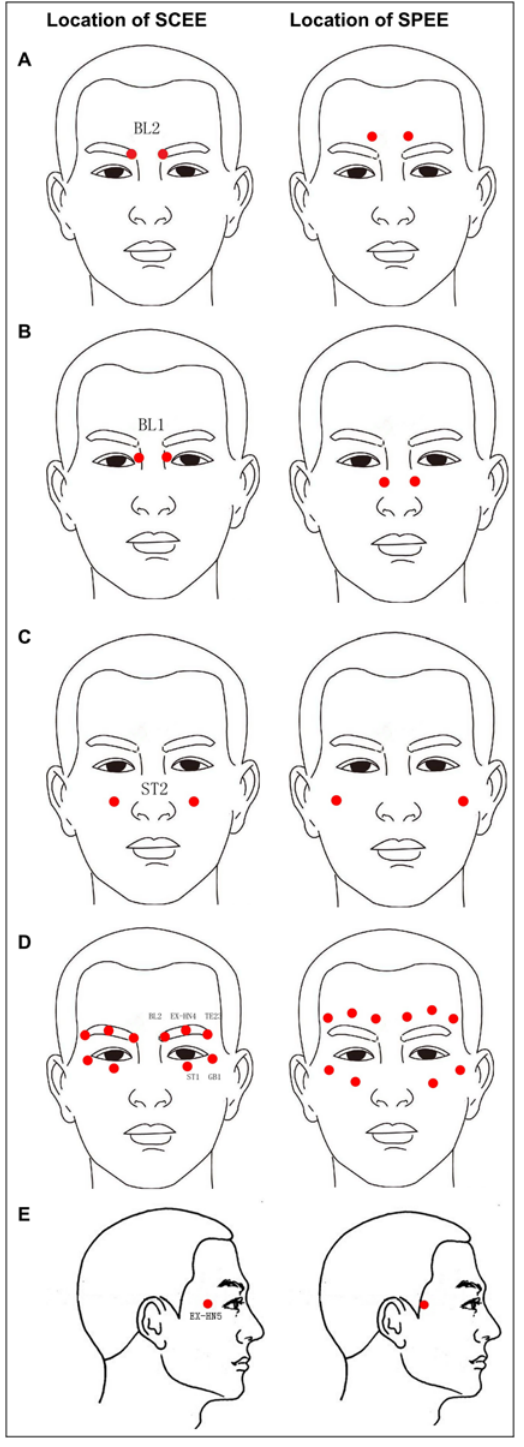
Fig 1. Locations of acupoints of standard Chinese eye exercises and sham point eye exercises.